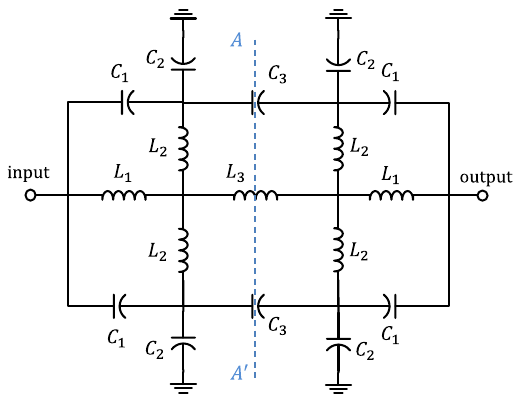
Figure 2: Equivalent LC circuit of the proposed LUC.